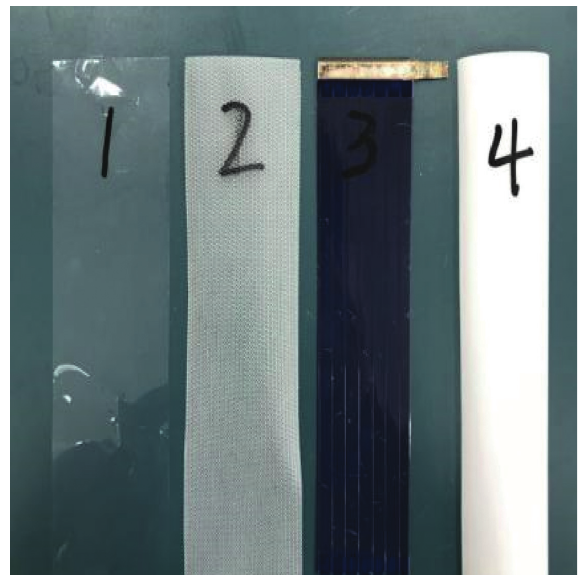
Figure 2: Composition material